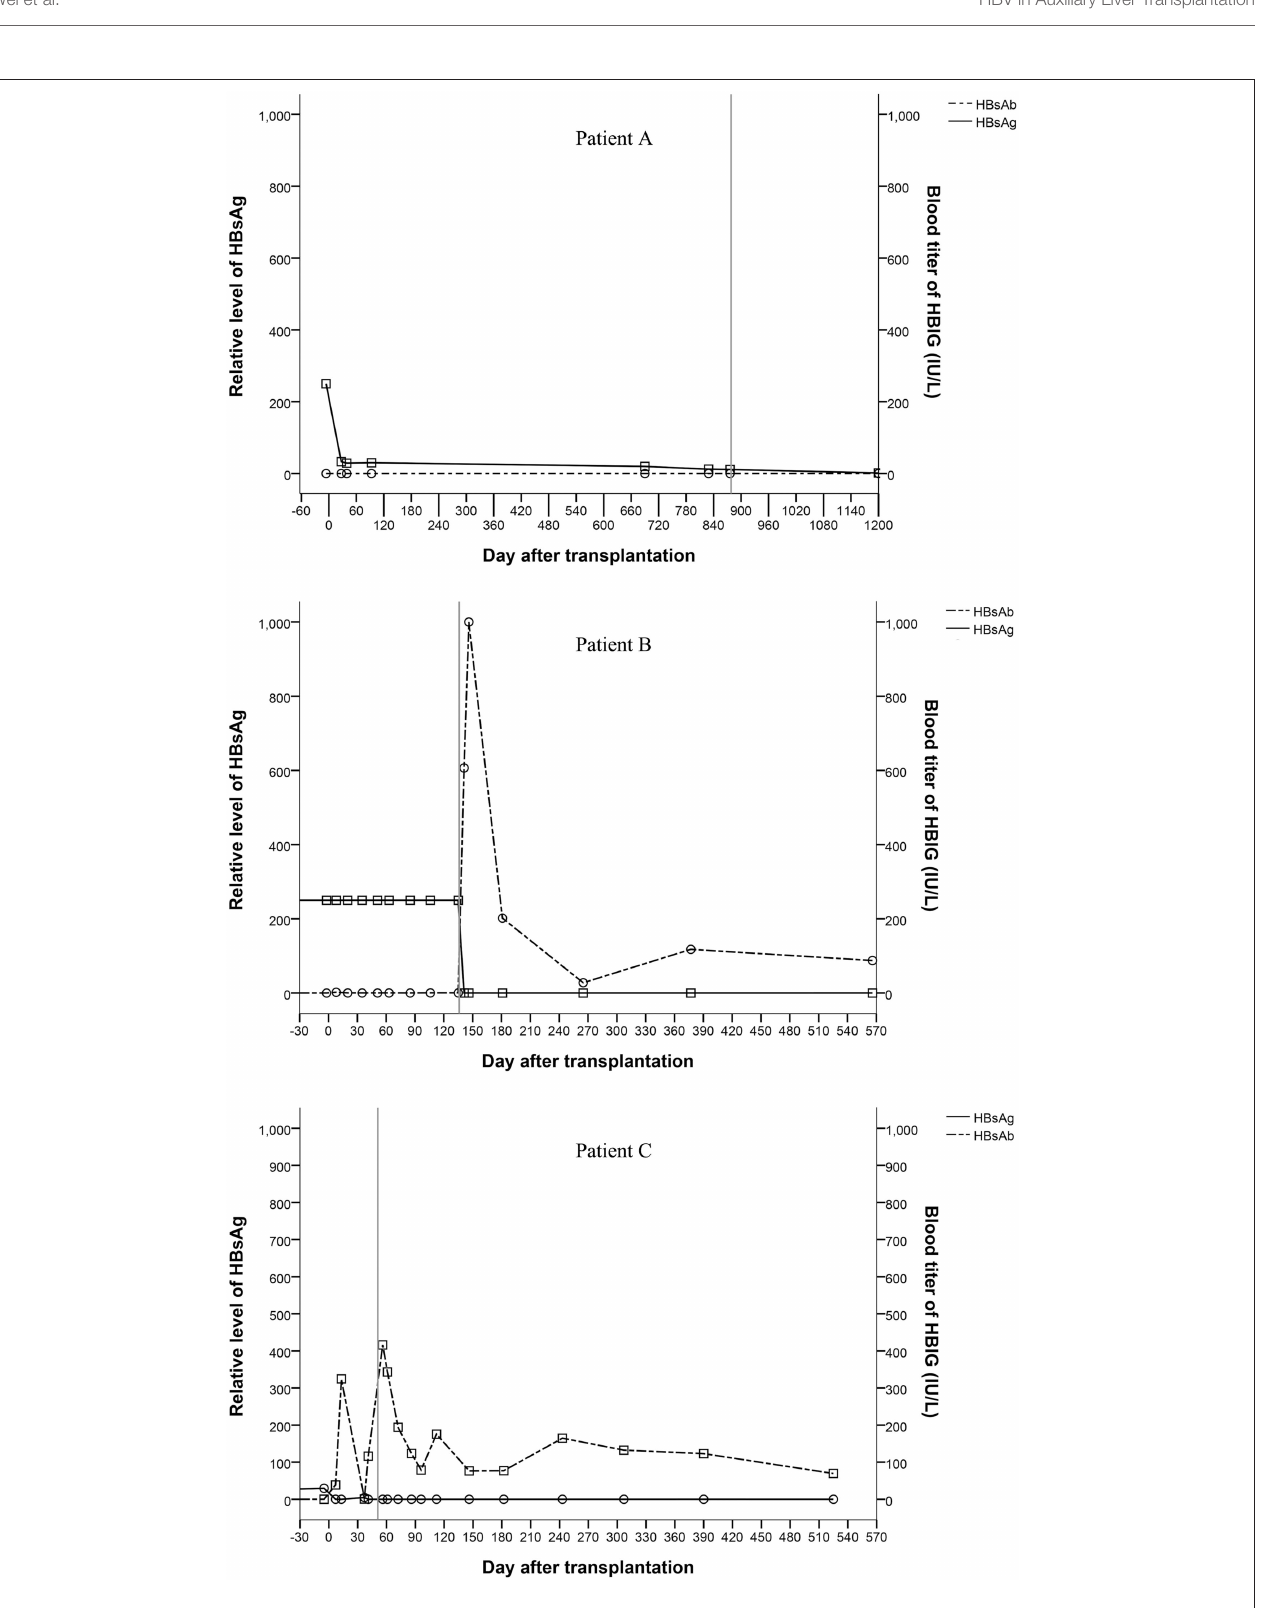
Frontiers in Medicine |